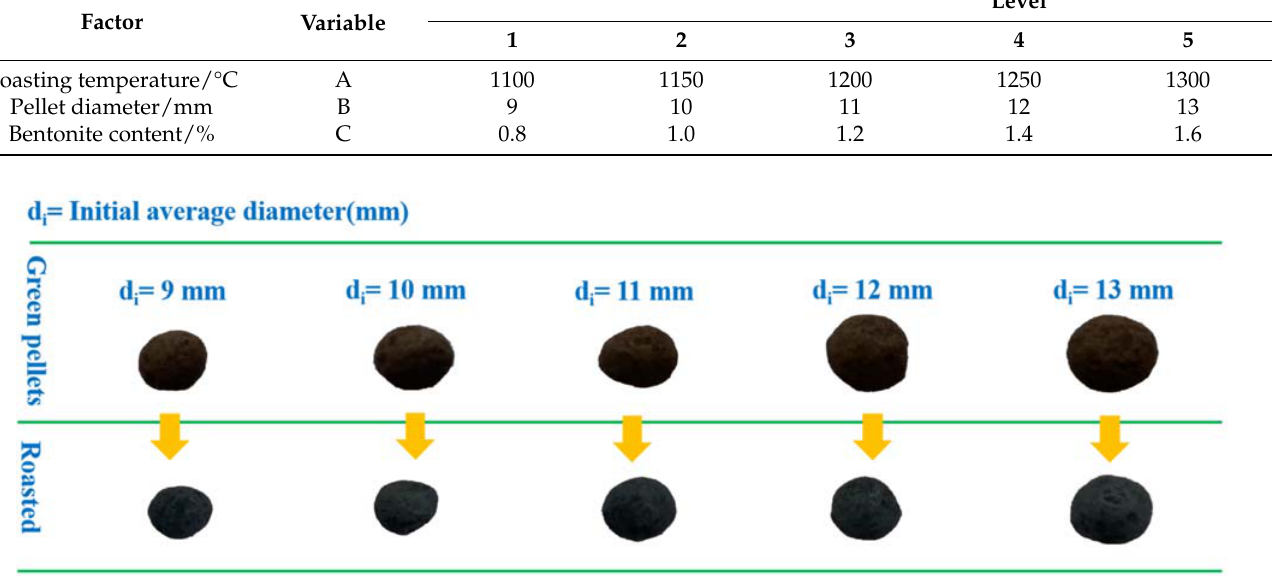
Figure 2. Different sizes of green pellets and roasted pellets.